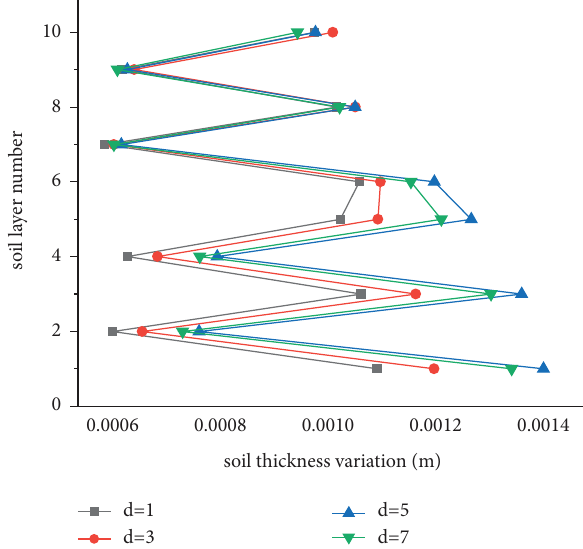
Figure 17: Variation in the thickness of each soil layer at diferent times at point B of the reinforced soil